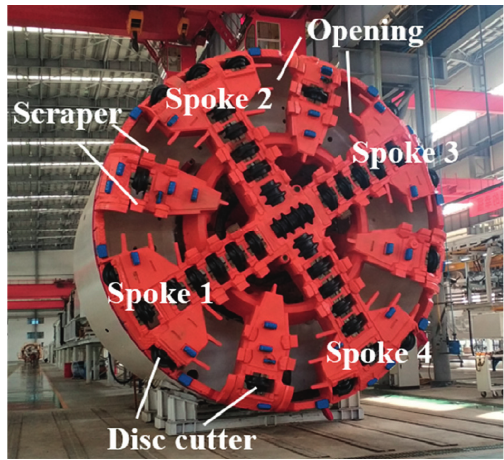
Figure 2: Cutter wheel of EPB shield used in Jinan Metro line R2.